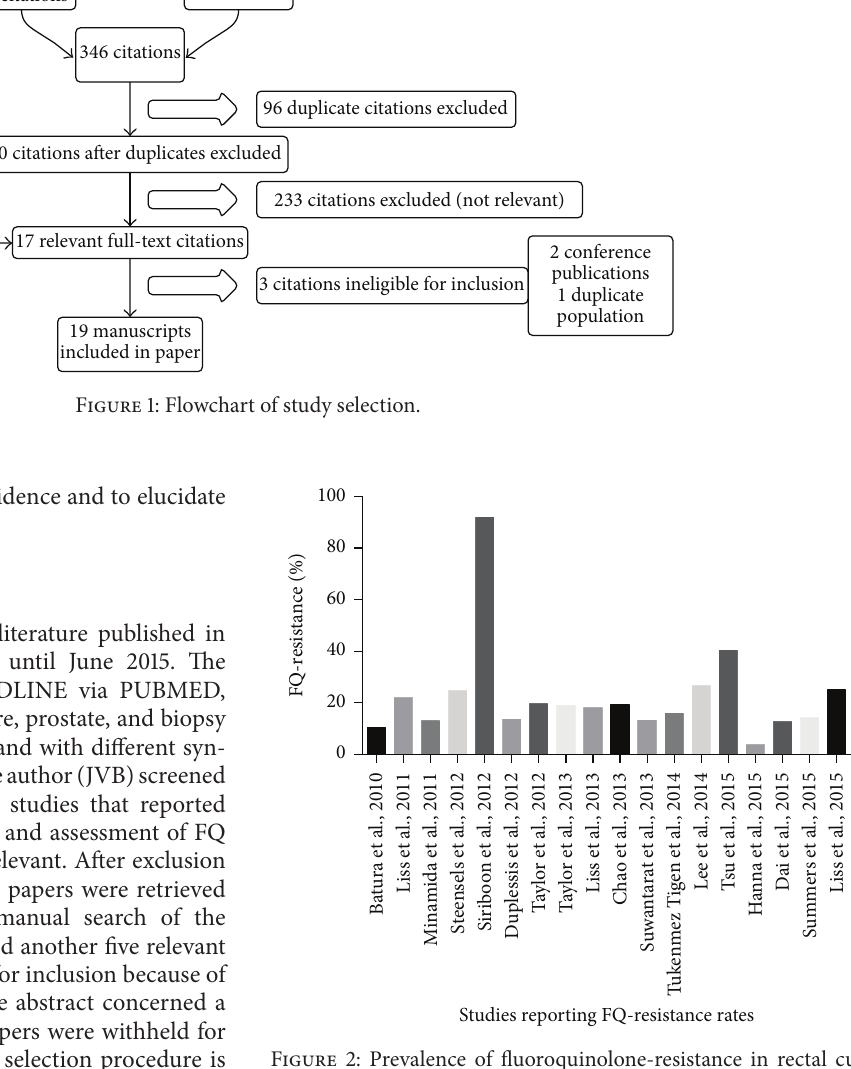
Figure 2: Prevalence of fluoroquinolone-resistance in rectal cul- tures prior to prostate